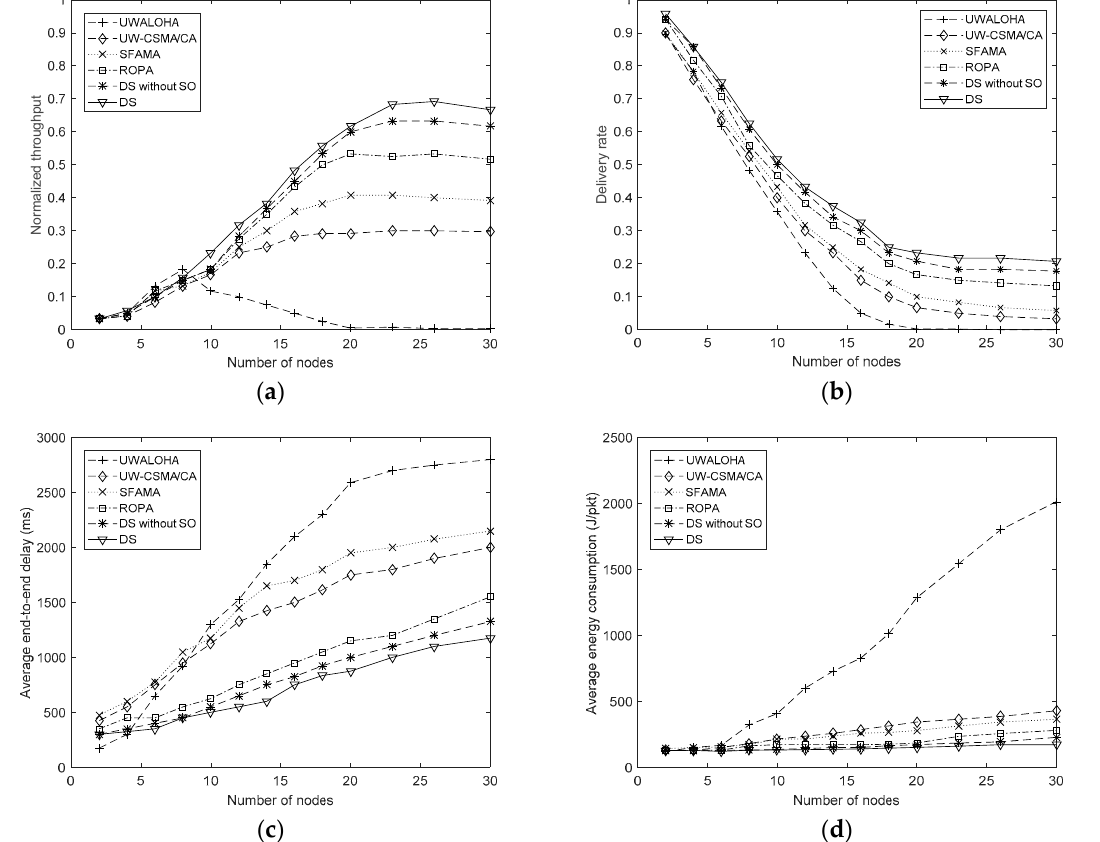
Figure 4. Performance of UWALOHA, UW-CSMA/CA, SFAMA, and ROPA protocols and that of the proposed method under different network sizes. ( a ) Normalized throughput; ( b ) Packet delivery rate; ( c ) Average end-to-end delay; ( d ) Average energy consumption.